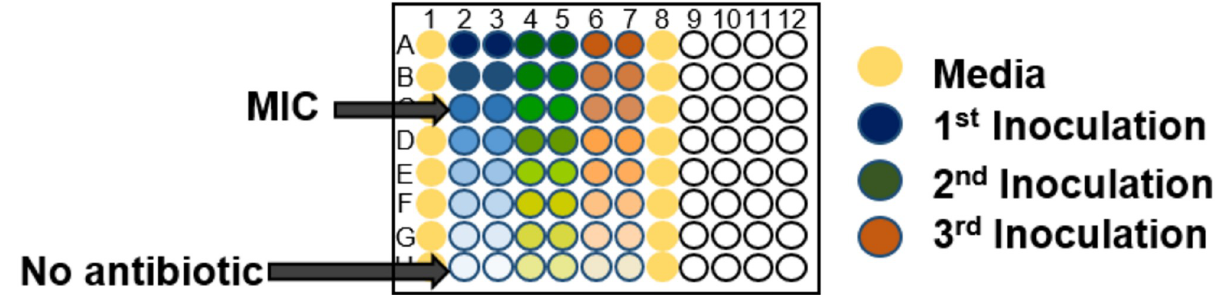
Fig 3. Plate setup for the delay-time bioassay. The entire plate is filled with media + antibiotics at the start of the experiment, with dilution series down the columns as indicated by the shading. The wells shown in yellow are media-only controls. The blue set of replicate columns are inoculated with bacteria immediately, and the plate is then incubated in a plate reader with OD measurement. The green set of columns are inoculated 2 hours later, the pink set of columns a further 2 hours later, etc. If the antibiotic has degraded between inoculations, this will be reflected in a change in the shape of the measured growth curves for later